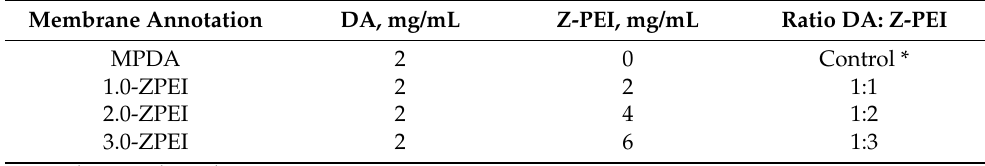
Table 2. DA and Z-PEI loading concentrations with their respective membrane annotations. Membrane